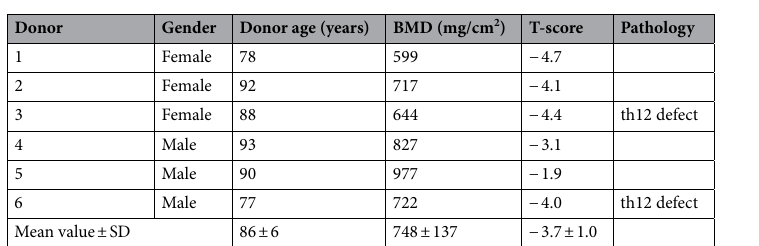
Table 4. Data of the body donor